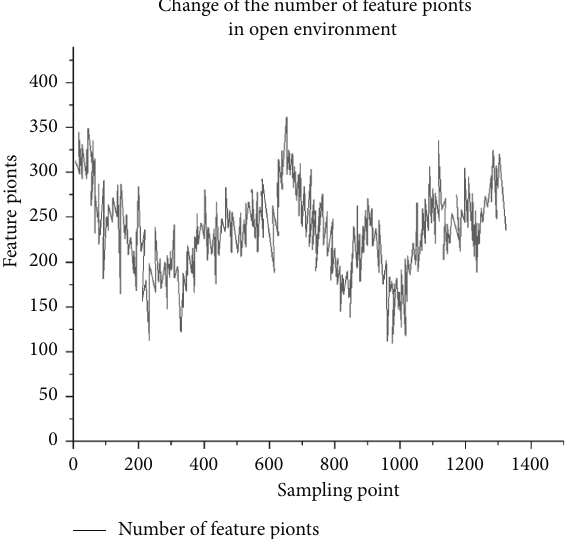
Figure 4: Variation of the number of feature points in an open